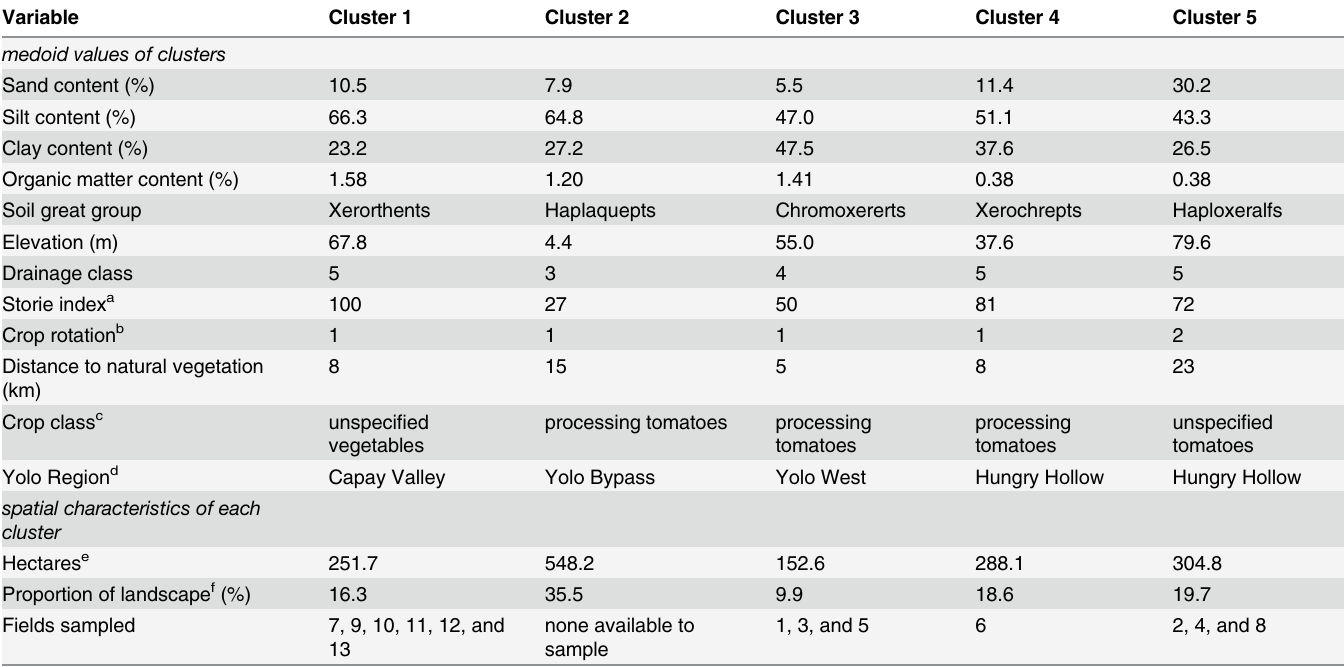
Table 2. Medoid values of the 12 GIS variables for each of five clusters, i.e. landscape